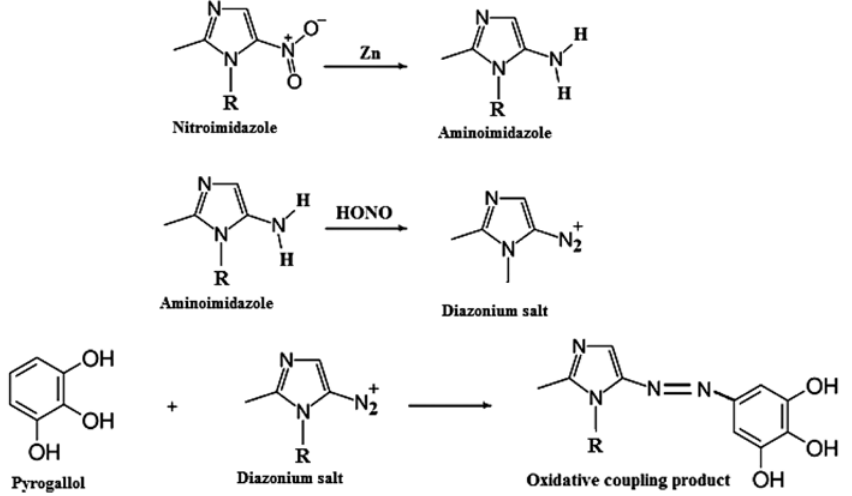
Figure 2: Reaction scheme of the developed methods.